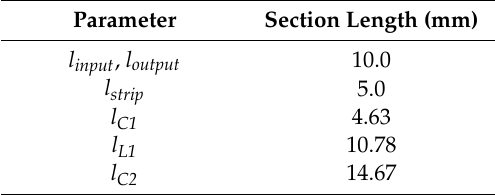
Table 4. Stripline homogenous filter section length.